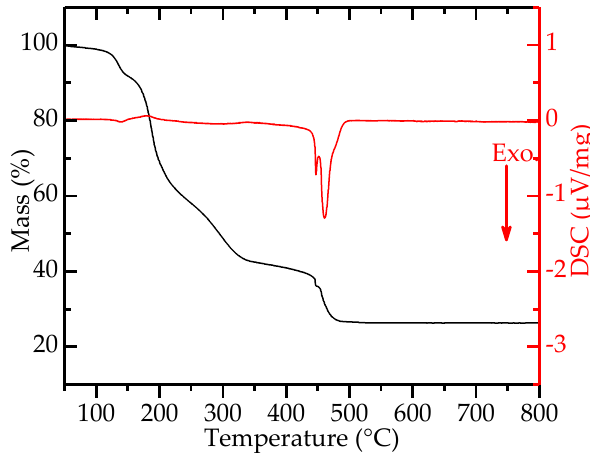
Figure A2. TGA measurement of BNT gel from nitrate method (10 °C/min ramp rate, synthetic air flow).